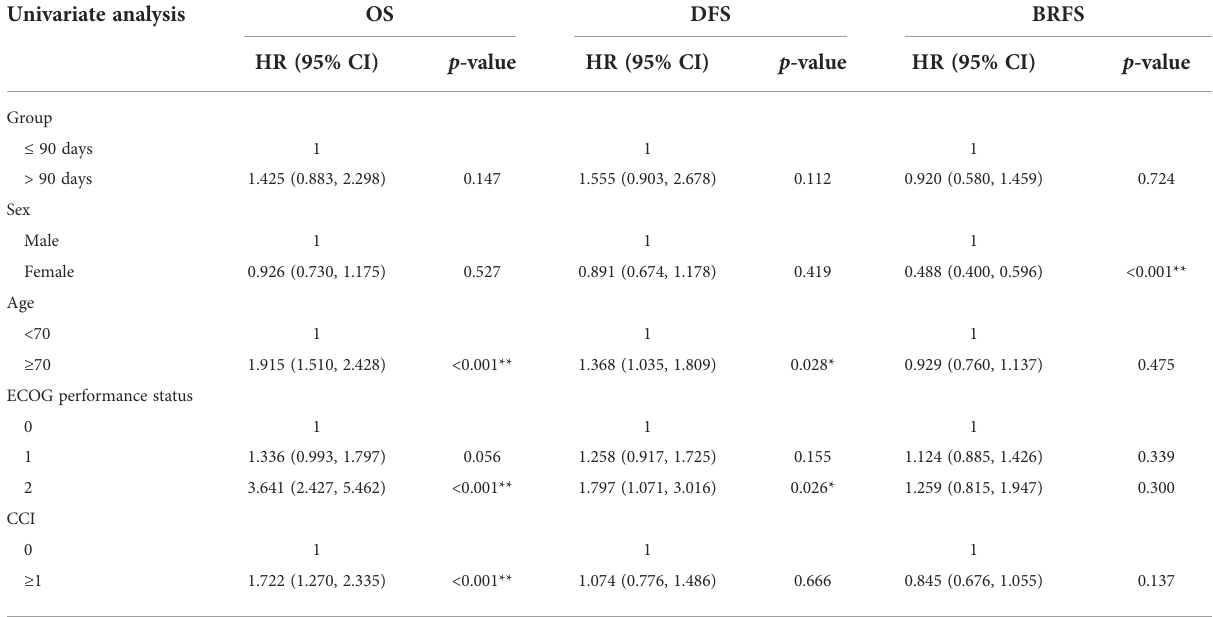
TABLE 2 Comparative univariate survival analysis the UTUC